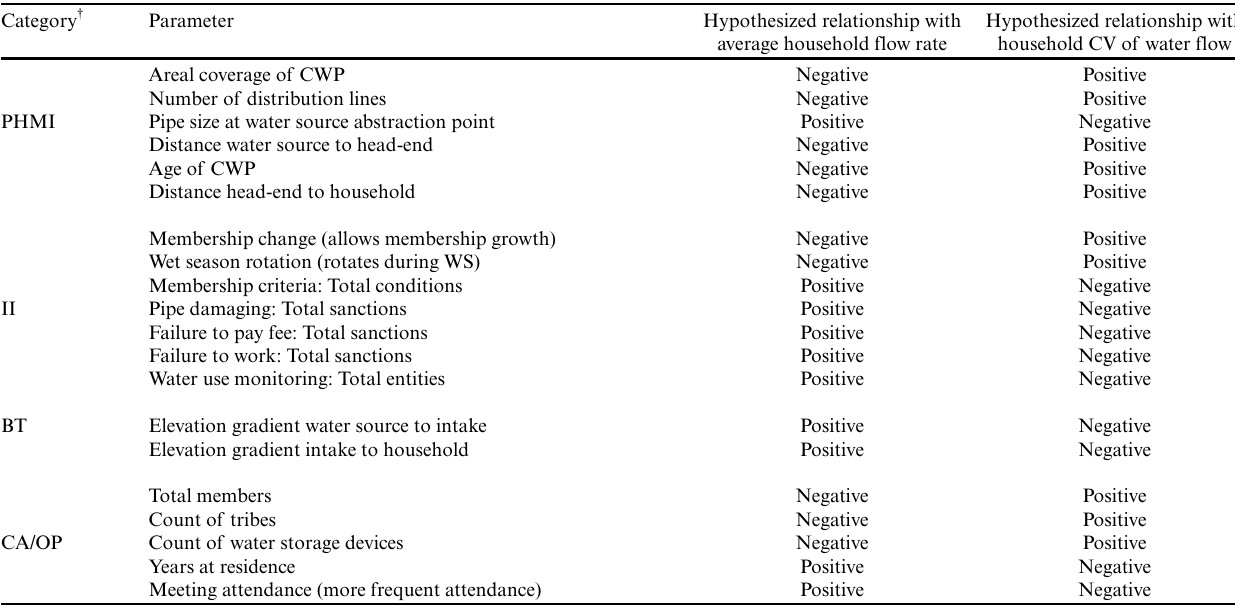
Table 5 . Hypothesized